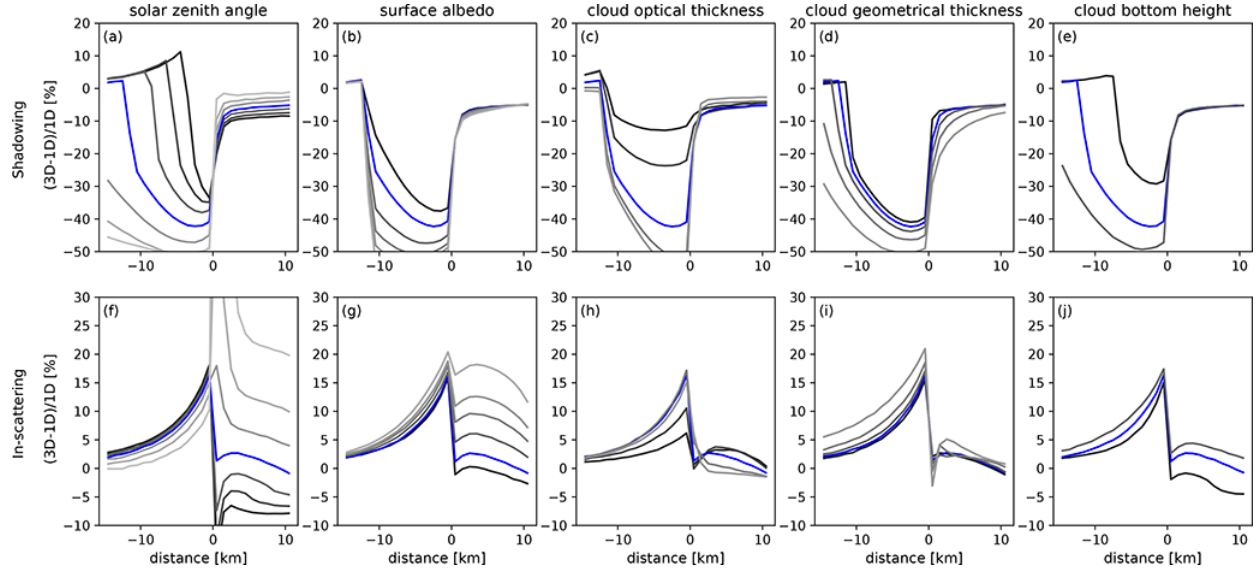
Figure 6. Same as Fig. 5 but for the ice water cloud at 9–10km altitude. All settings are summarized in Table 1.